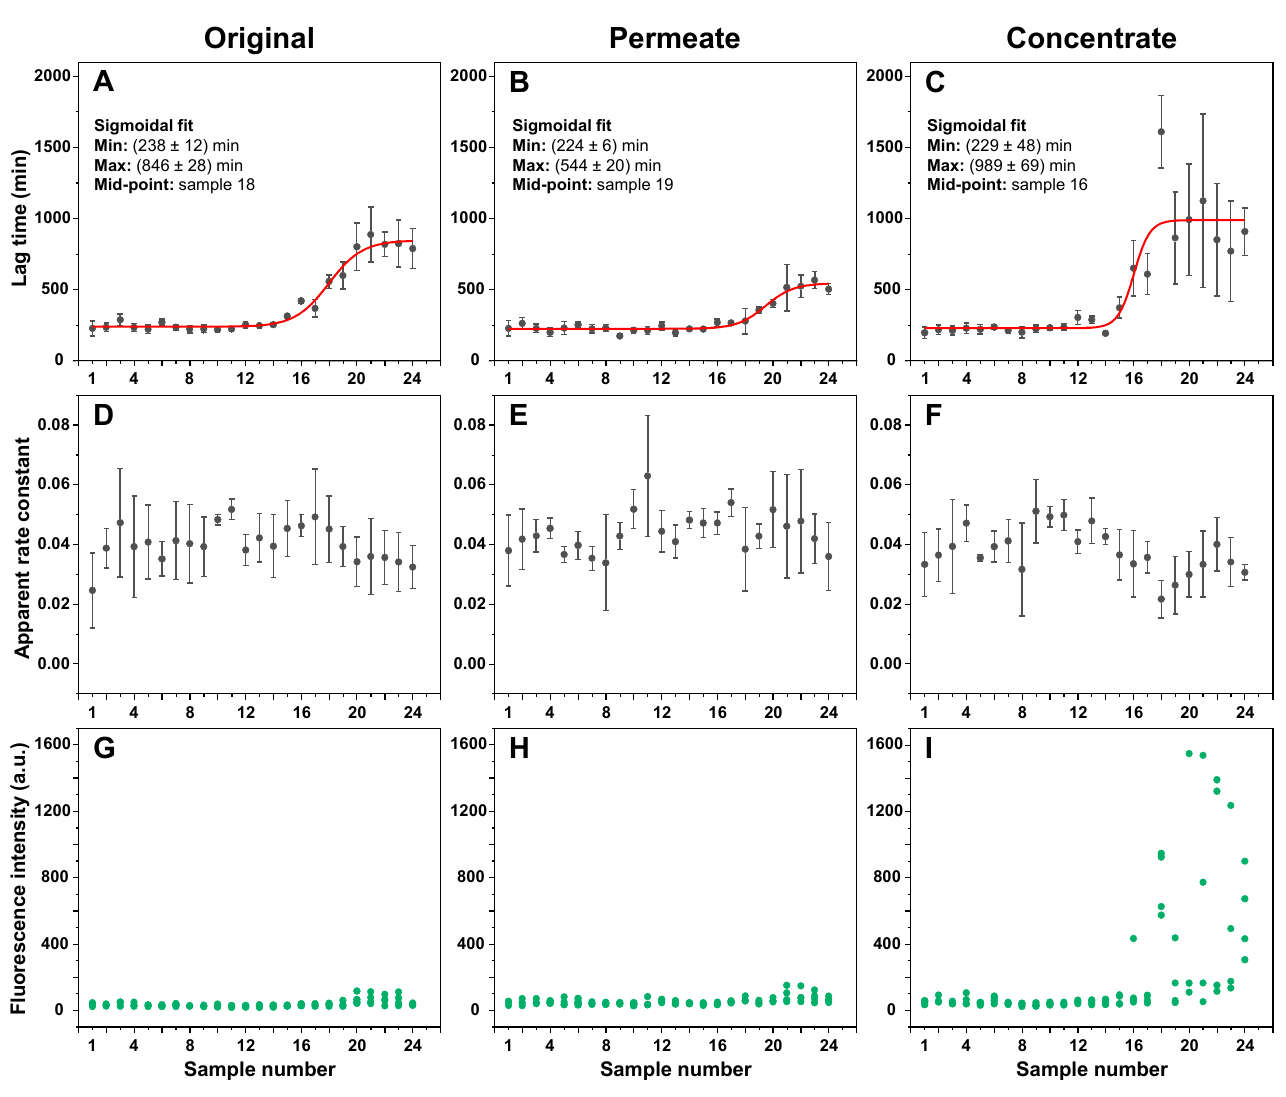
Figure 2. Insulin aggregation kinetic parameters in the presence of different incubation time EGCG samples. Insulin aggregation lag times when in the presence of original ( A ), permeate ( B ), and concentrate ( C ) EGCG samples, their elongation apparent rate constants ( D – F respectively), and sample bound-ThT fluorescence intensities at the end of the reaction ( G – I respectively). EGCG sample preparation is described in the Materials and Methods section. Aggregation lag time, apparent rate constant, and sample fluorescence intensity values were determined as shown in Appendix A, Figure A1 (n = 4, error bars are for one standard deviation). Examples for aggregation kinetic curves of samples 1 and 24 are shown in Appendix A, Figure A3. Inserts in subfigures ( A – C ) show the minimum and maximum lag time values and mid-point of the sigmoidal fit.